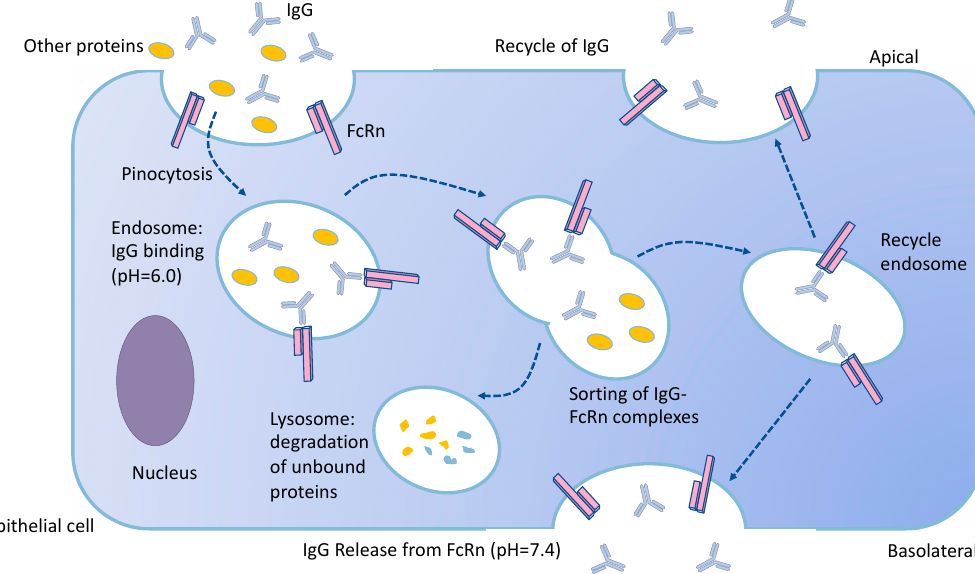
Figure 2. Transport and recycle of IgG in the lung epithelium by the FcRn-mediated pathway. IgG is taken up into FcRn-expressing epithelial cells via non-specific fluid-phase pinocytosis. IgG then binds to the transport receptor, FcRn, which is mainly distributed within the acidic endosomal vesicles in the cell. The Fc receptor binds to IgG with high affinity at low pH but shows no affinity at physiologic pH. FcRn with bound IgG is sorted into the sorting endosome, which either recycle or transcytose to the plasma membrane. Nonprotected IgG and proteins proceed to lysosomal proteolytic degradation. The near-neutral pH results in dissociation and release of IgG from FcRn into the extracellular fluid.